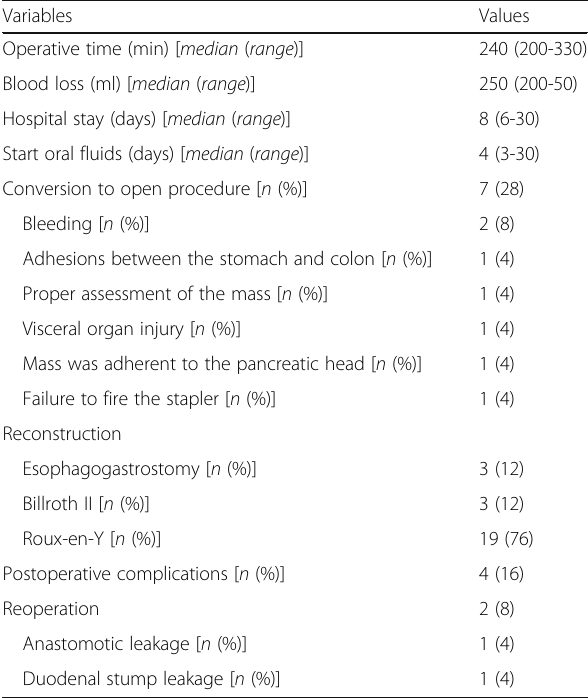
Table 3 Perioperative data ( n = 25) Variables